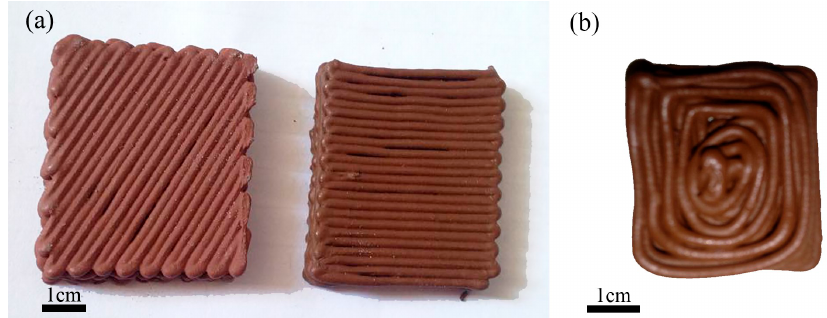
Figure 4. Green samples printed by this method with: ( a ) appropriate printing conditions; ( b ) inappropriate printing conditions.